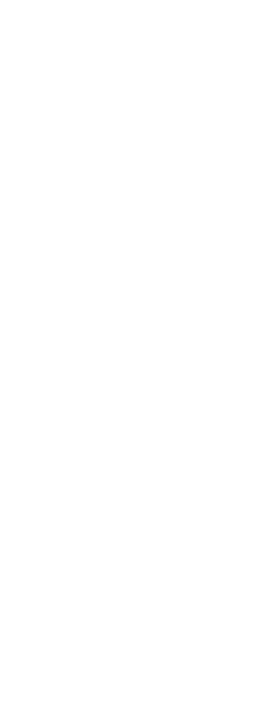
Figure 1 Top 20 government donors to United Nations Relief and Works Agency (UNRWA) in 2015, with the amount donated in US